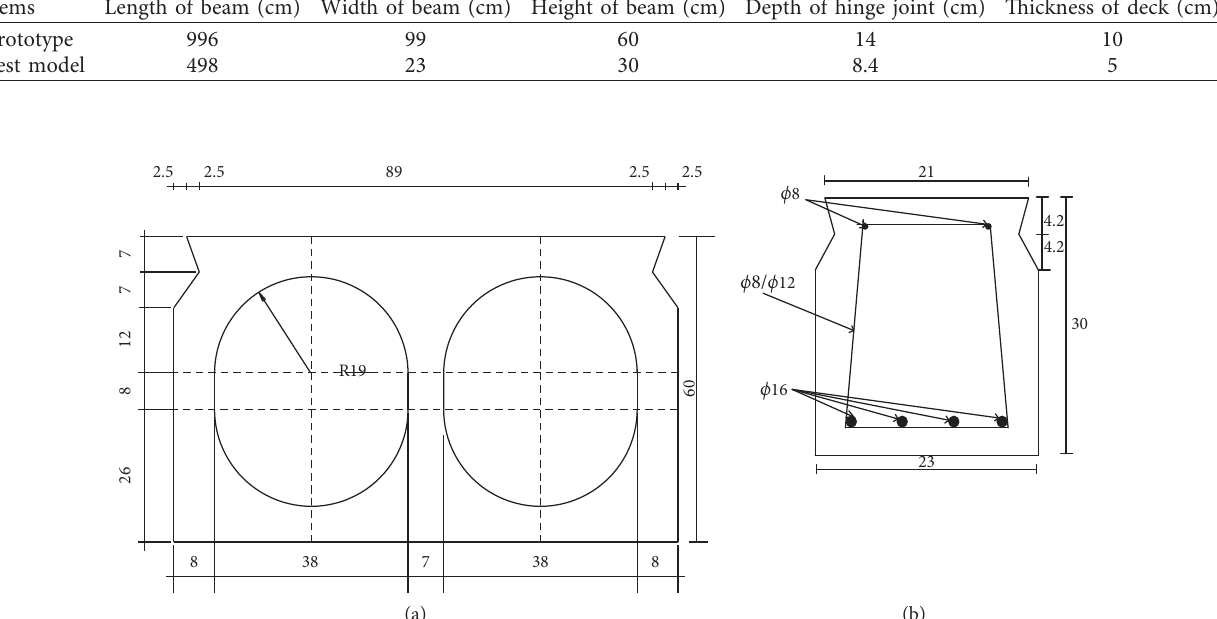
Figure 4: Cross section of the prototype and model beam (unit: cm). (a) Prototype beam cross section. (b) Model beam cross section.